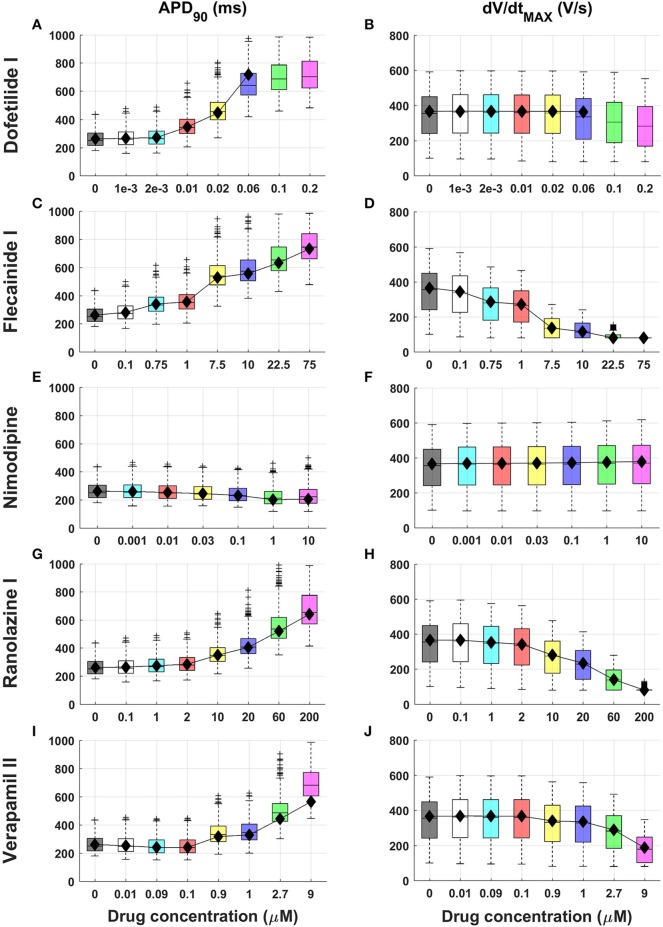
Explanatory examples of in silico drug trial results in a population of human computational models, showing drug-induced changes on APD90 and dV/dtMAX (left and right column, respectively) for 5 compounds (Dofetilide I, Flecainide I, Nimodipine, Ranolazine I and Verapamil II). Results are presented as boxplots of AP biomarkers for the population of human ventricular models at increasing concentrations (A–J). Results for the single ORd model are shown as black diamonds. On each box, the central mark is the median of the population, box limits are the 25 and 75th percentiles, and whiskers extend to the most extreme data points not considered outliers, plotted individually as separate crosses. Extended results for the selected 15 reference compounds, including all the AP biomarkers, are available in the Supplementary Material, Figures S3–S31.